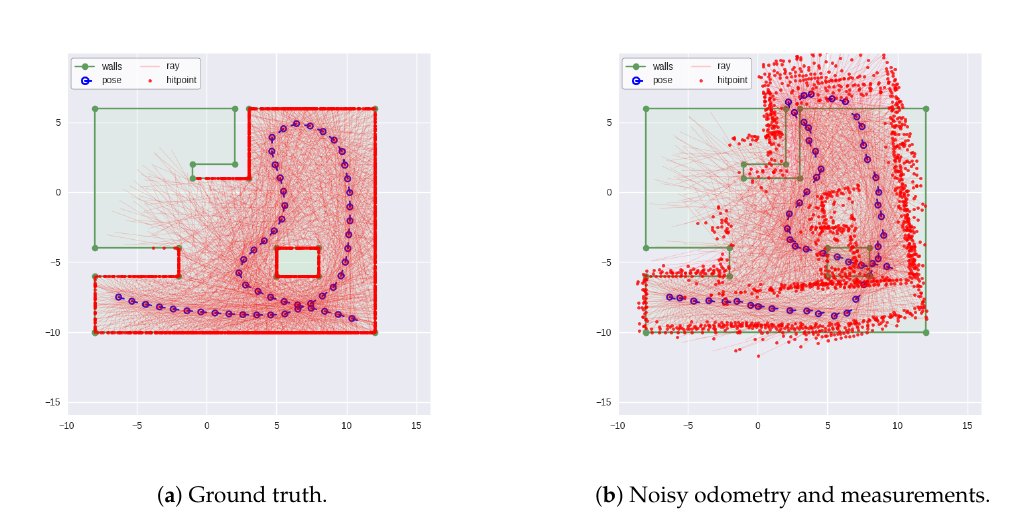
Figure 5. Simulated dataset of an indoor environment. Vehicle starting position on the bottom